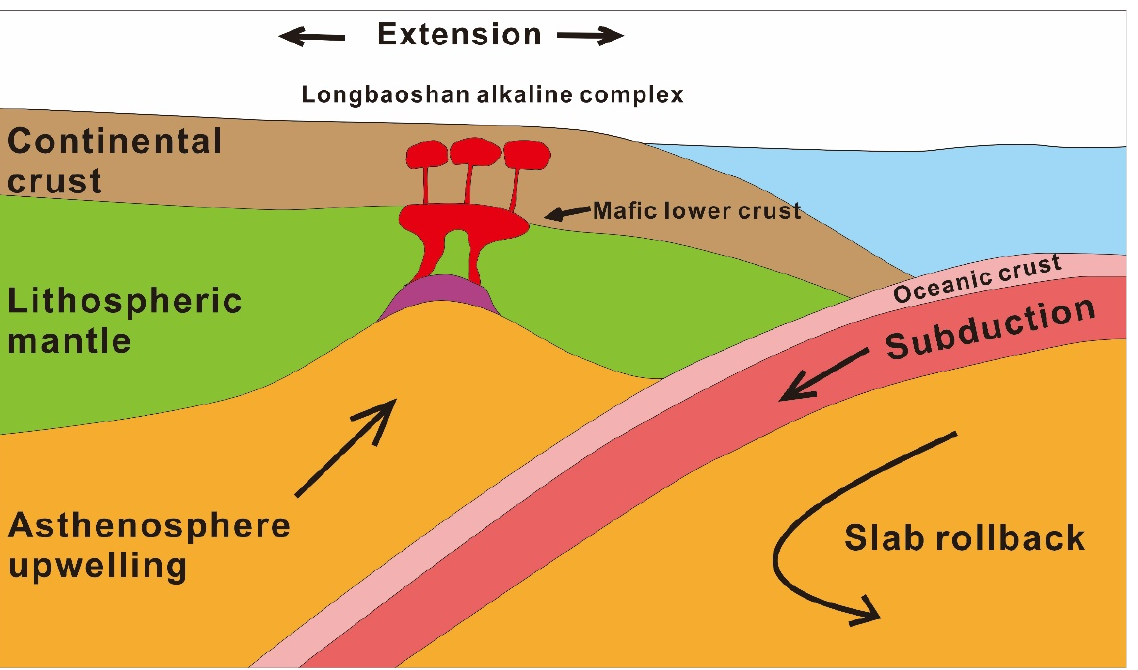
Figure 15. Tectonic schematism showing the formation of the alkaline complex in the Longbaoshan area of Luxi Terrane [40,106,107].